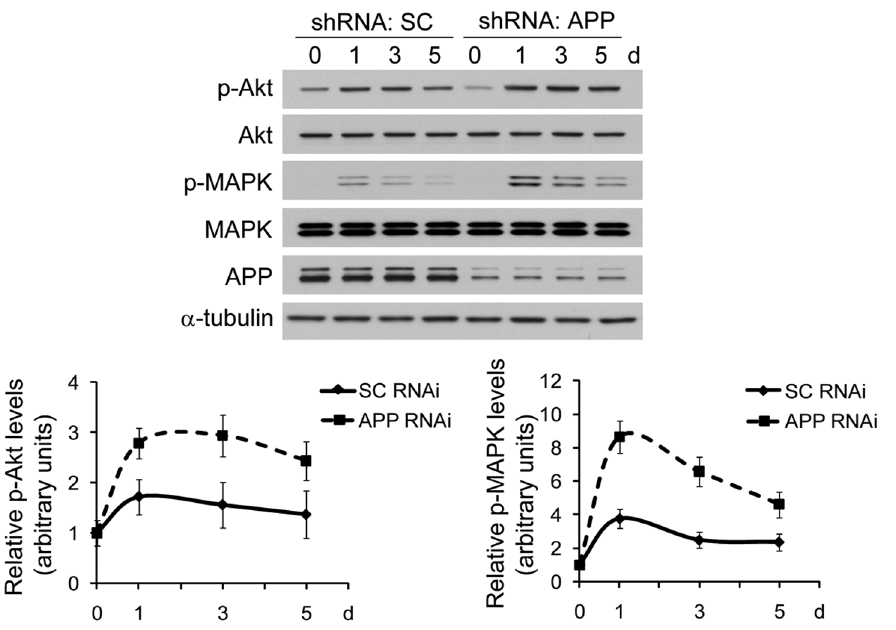
Figure 4. APP deficiency enhances activation of Akt and MAPK upon NGF treatment. PC12 cells stably expressing APP shRNA and control cells expressing scrambled control (SC) shRNA were treated with 100 ng/mL NGF for the indicated time periods. Equal protein amounts of cell lysates were subjected to Western blotting to measure phosphorylation (p)/activation of Akt and MAPK. Protein levels were quantified by densitometry and normalized to those of controls for comparison (set as one arbitrary unit). Error bars indicate SEM,